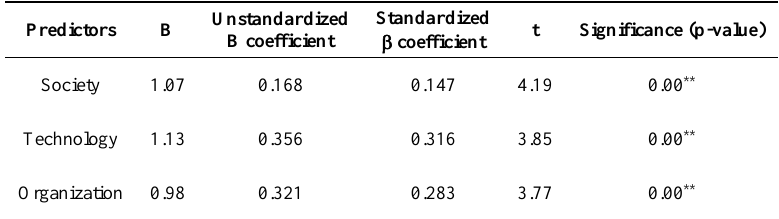
Table 11. Regression results on the impact of digital transformation on administrative procedure reform